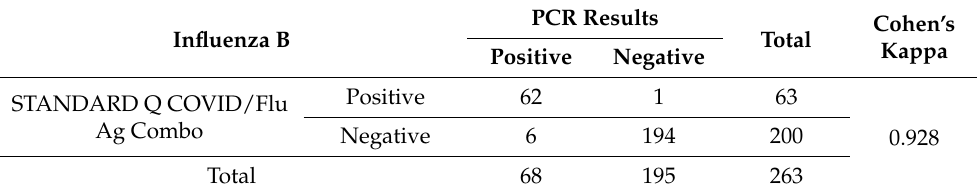
Table 3. Diagnostic performance of the STANDARD Q COVID/FLU Ag Combo compared to the real-time PCR for detection of influenza